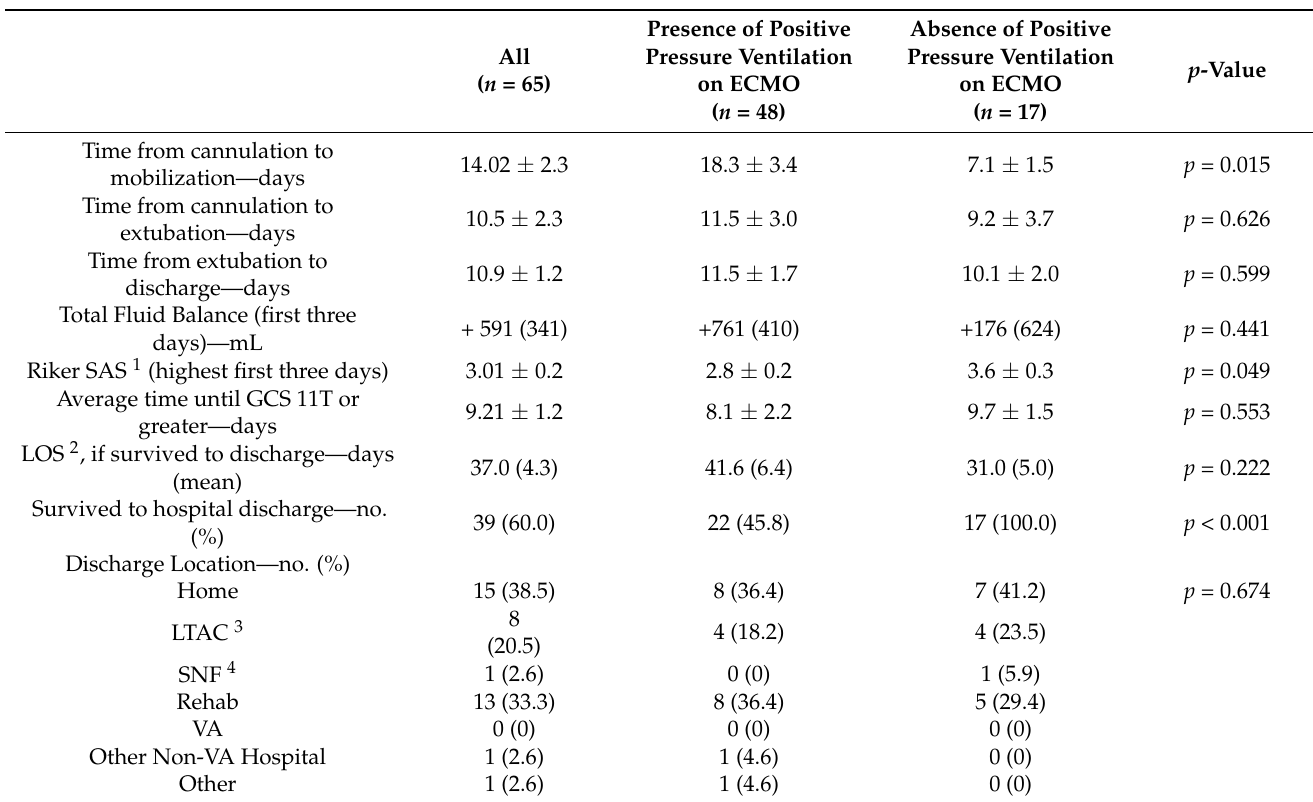
Table 3. Primary and secondary measured outcomes.